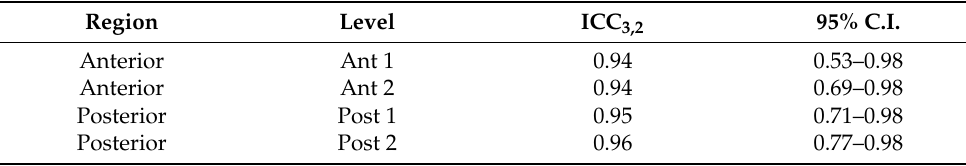
Table 3. Intra-rater reliability of the ultrasound measurements within different regions/levels of the deep fascia of the arm between two sessions by